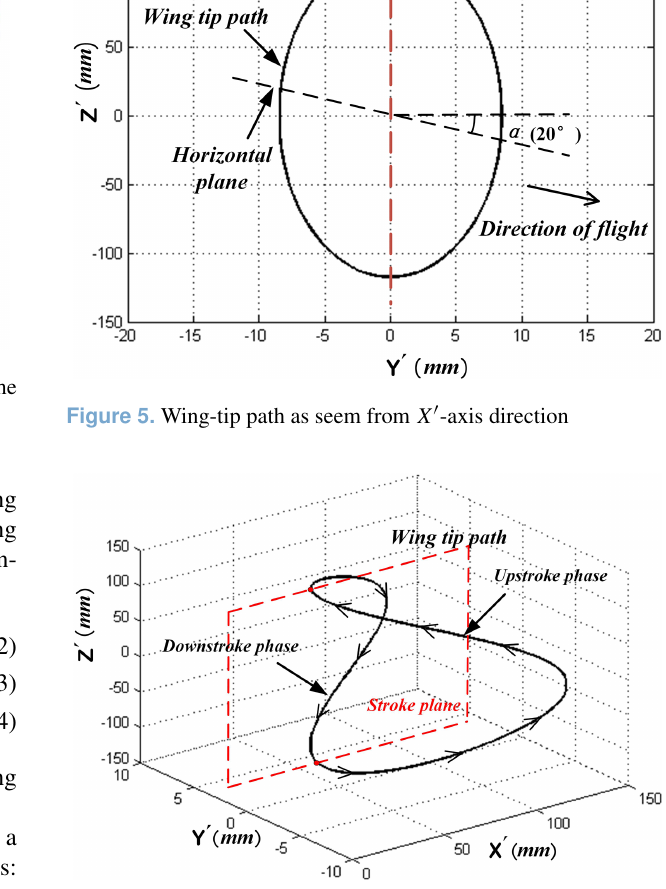
Figure 6. Wing-tip path in three-dimensional